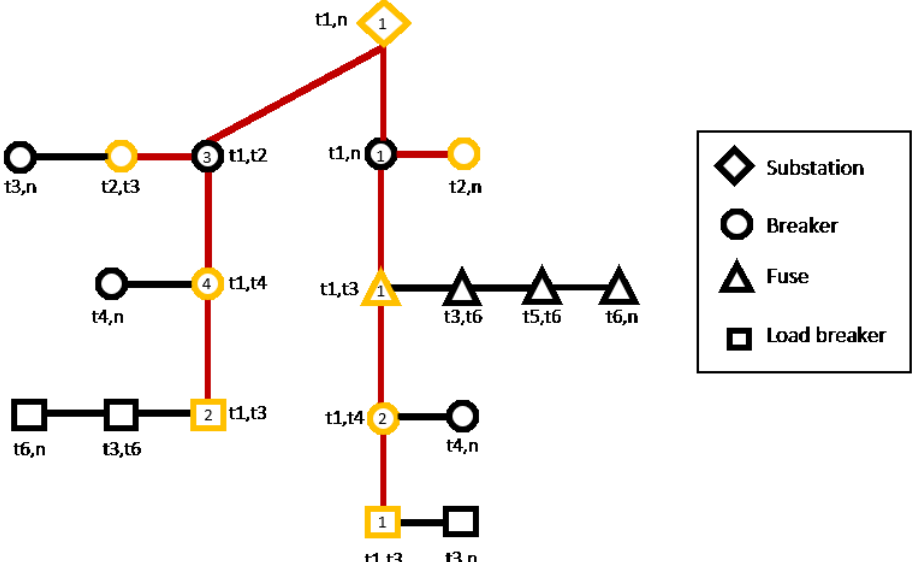
Figure 13. Obtaining the state of a network model (approach 1).